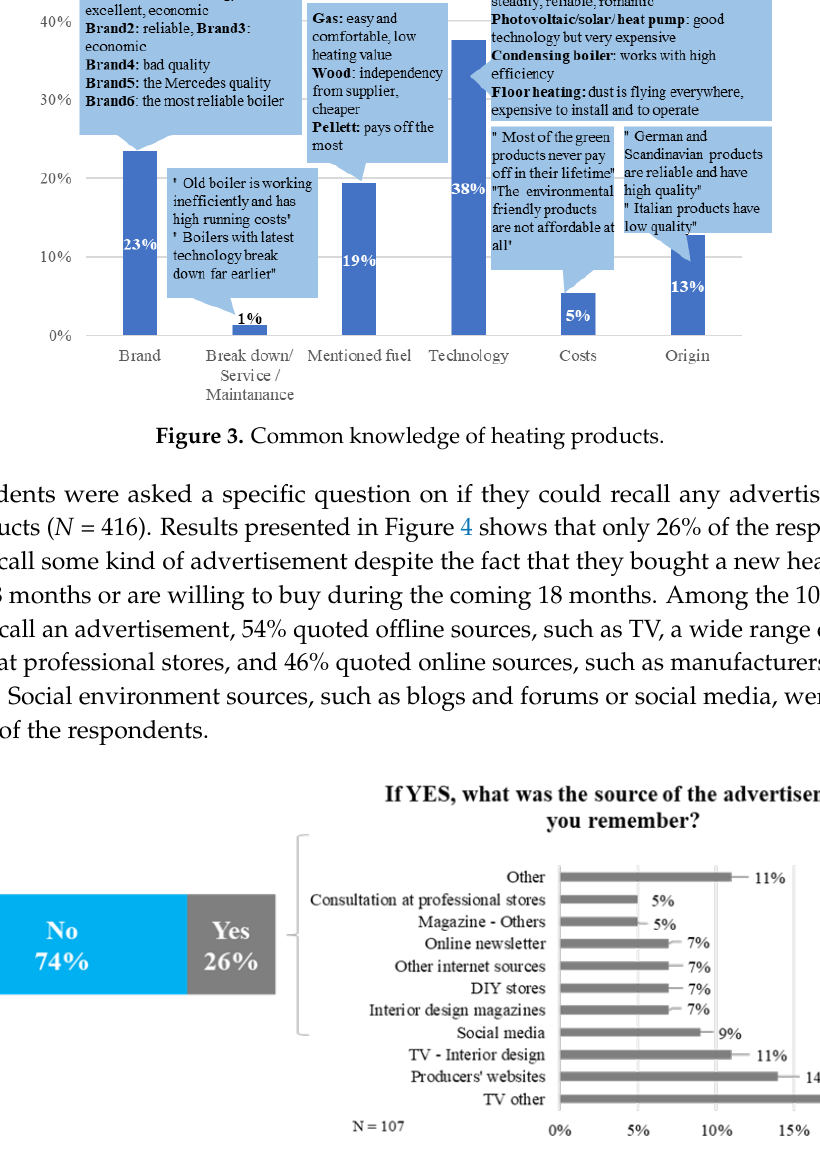
Figure 5. The customers initial purchase situation and the influence of sources of information.